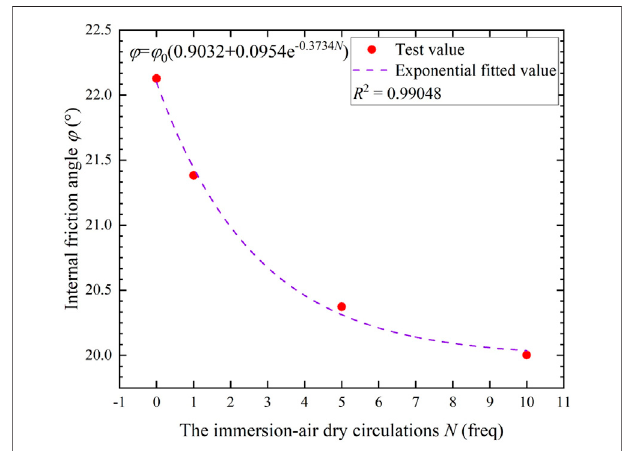
FIGURE 14 | Internal friction angle deterioration evolution curve of S-RMs.